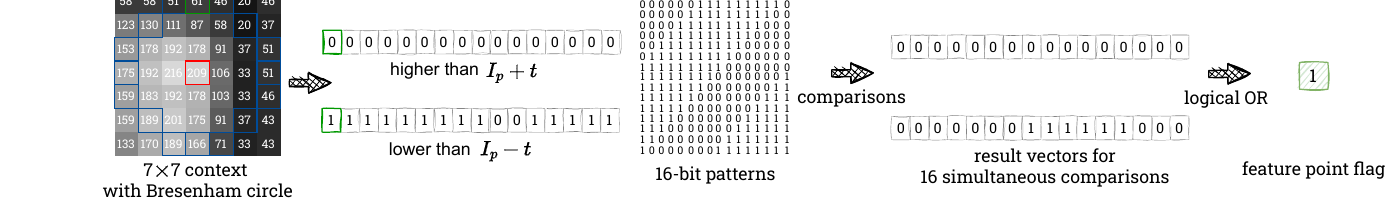
Figure 5. Determining the feature point flag for an exemplary image patch. In that case none of the 16 pixels on the Bresenham circle have an intensity above I p + t (229 for t = 20), while 14 of them have an intensity below I p − t (189). This results in two 16-bit vectors, which are compared with 16 different patterns, each consisting of 16 bits: 9 ones and 7 zeros. The vector representing pixels with intensity higher than I p + t does not match any pattern, while the second one matches 6 different patterns in total. Therefore, we determine the centre pixel is a feature point (it fulfils the FAST’s “lower than”